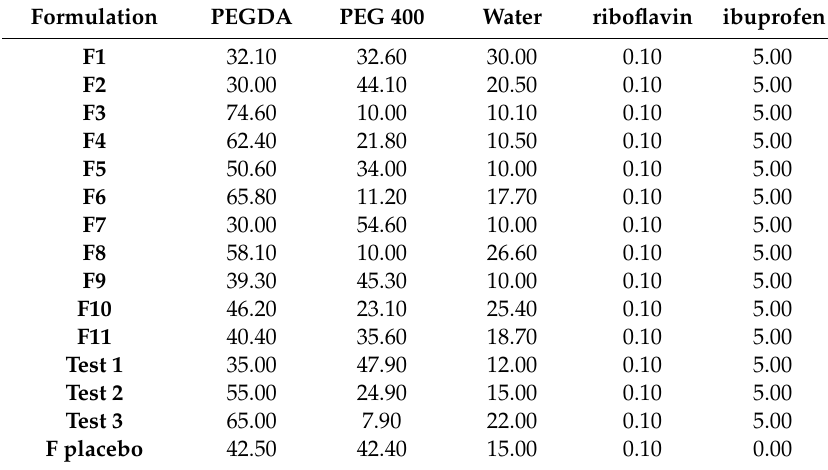
Table 1. Composition (% w / w ) of the initial resins used to print the printlets.